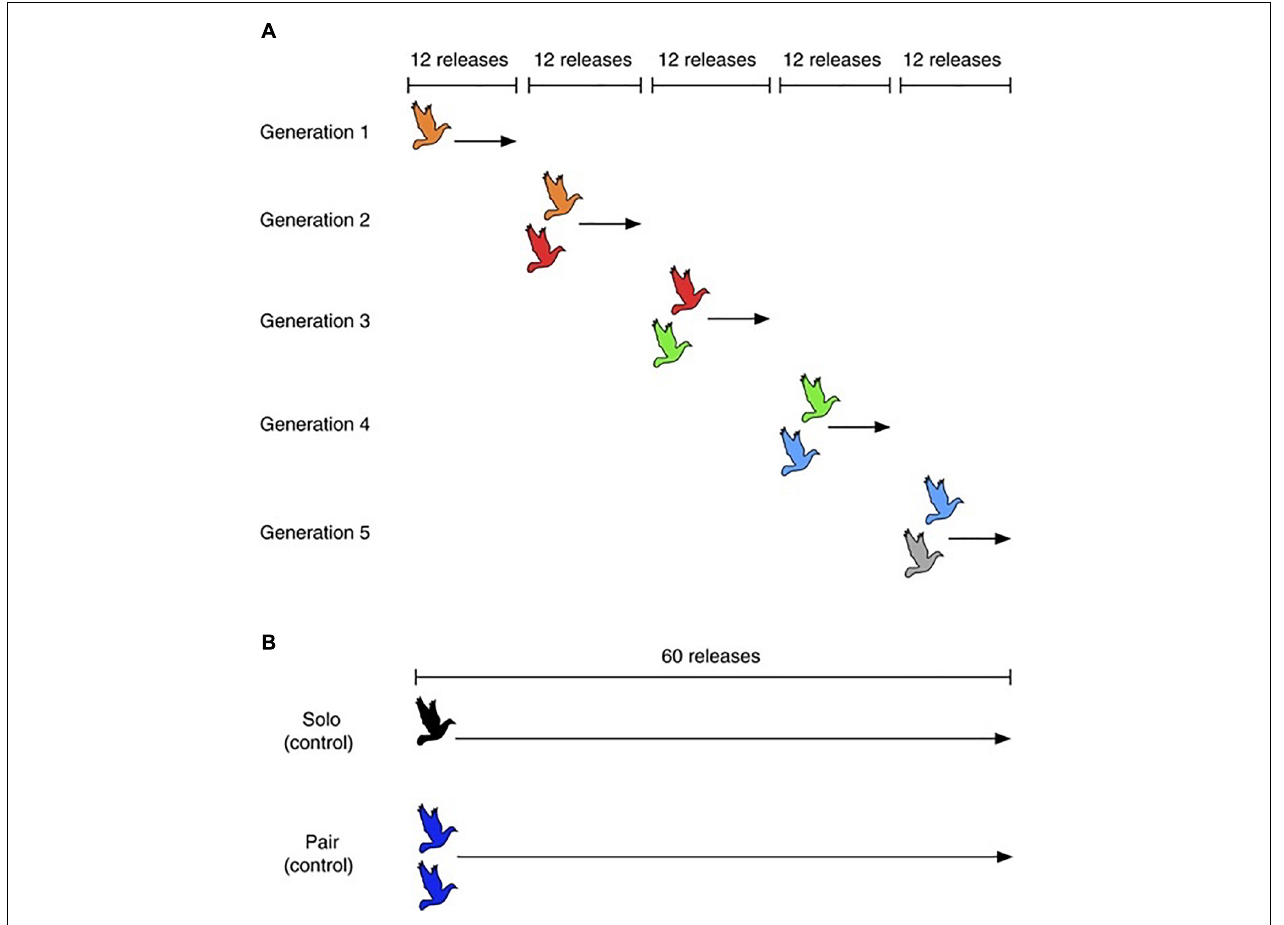
FIGURE 2 | From Sasaki and Biro (2017): “Homing flight release protocols. (A) Experimental group and (B) control groups. In each chain of the experimental group, a single pigeon (orange) was first released from the same site repeatedly 12 times, then partnered with a naive pigeon (red) and flown as a pair a further 12 times. The first bird was then replaced by a third bird (green) and this new pair (red þ green) was also released 12 times. This procedure continued until the fifth-generation bird (grey) was added and flown a final 12 times. In the control groups (B) , single pigeons and fixed pairs were released the same number of times as the total flown by the experimental group (60 flights). All three treatment groups contained 10 independent replicates (chains, solo birds, or